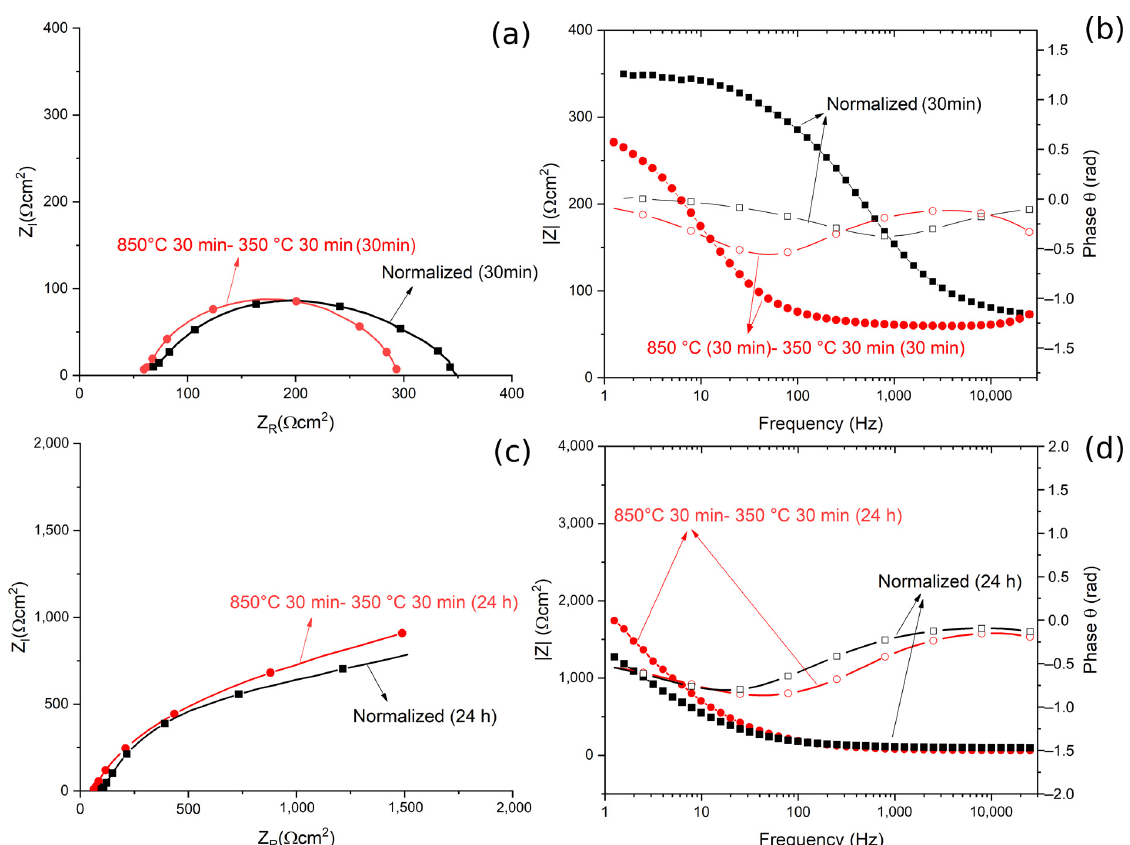
Figure 13. ( a ) Nyquist plot for the material austempered at 350 ◦ C after austenitizing at 850 ◦ C and in normalized conditions for 30 min immersion. ( b ) Bode modulus and phase plot for or the material austempered at 350 ◦ C after austenitizing at 850 ◦ C and in the normalized condition for 30 min immersion. ( c ) Nyquist plot for the material austempered at 350 ◦ C after austenitizing at 850 ◦ C, and in normalized condition for 24 h immersion. ( d ) Bode and phase plots for the material austempered at 350 ◦ C after austenitizing at 850 ◦ C and in normalized condition for 24 h immersion. All the tests were performed in borate buffer solution. Dots represent experimental data, lines the results of the